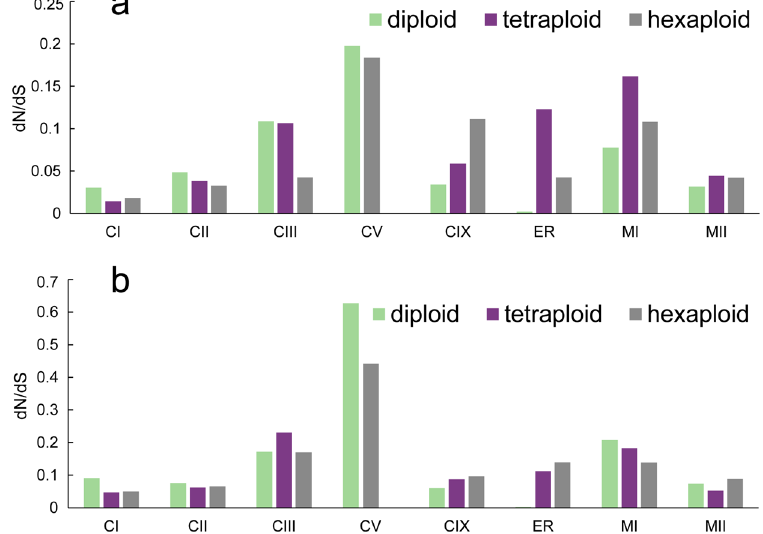
Figure 4. Selection pressure variation during wheat polyploidization. ( a ) The selection pressures acting on the ACD domain region. ( b ) The selection pressures acting on the full sHSPs. The X axis represents the different sHSP subfamilies and Y axis represents the dN/dS value.The dN/dS values were estimated based on the total sHSPs of diploid, tetraploid and hexaploid genomes, respectively. If the sHSP number was lower than three, the dN/dS value was not